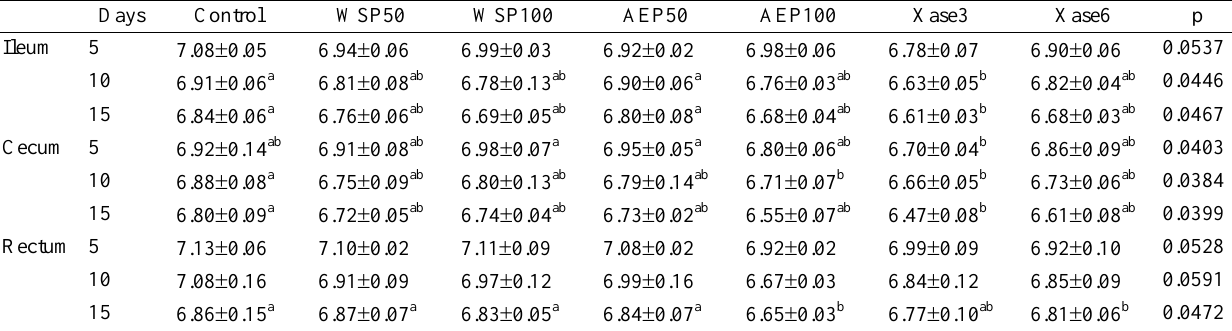
Table 5. Effects of pentosans and xylanase on the chime pH in the gut